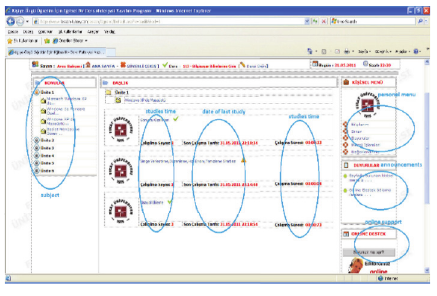
Figure 3: Student’s subject page.